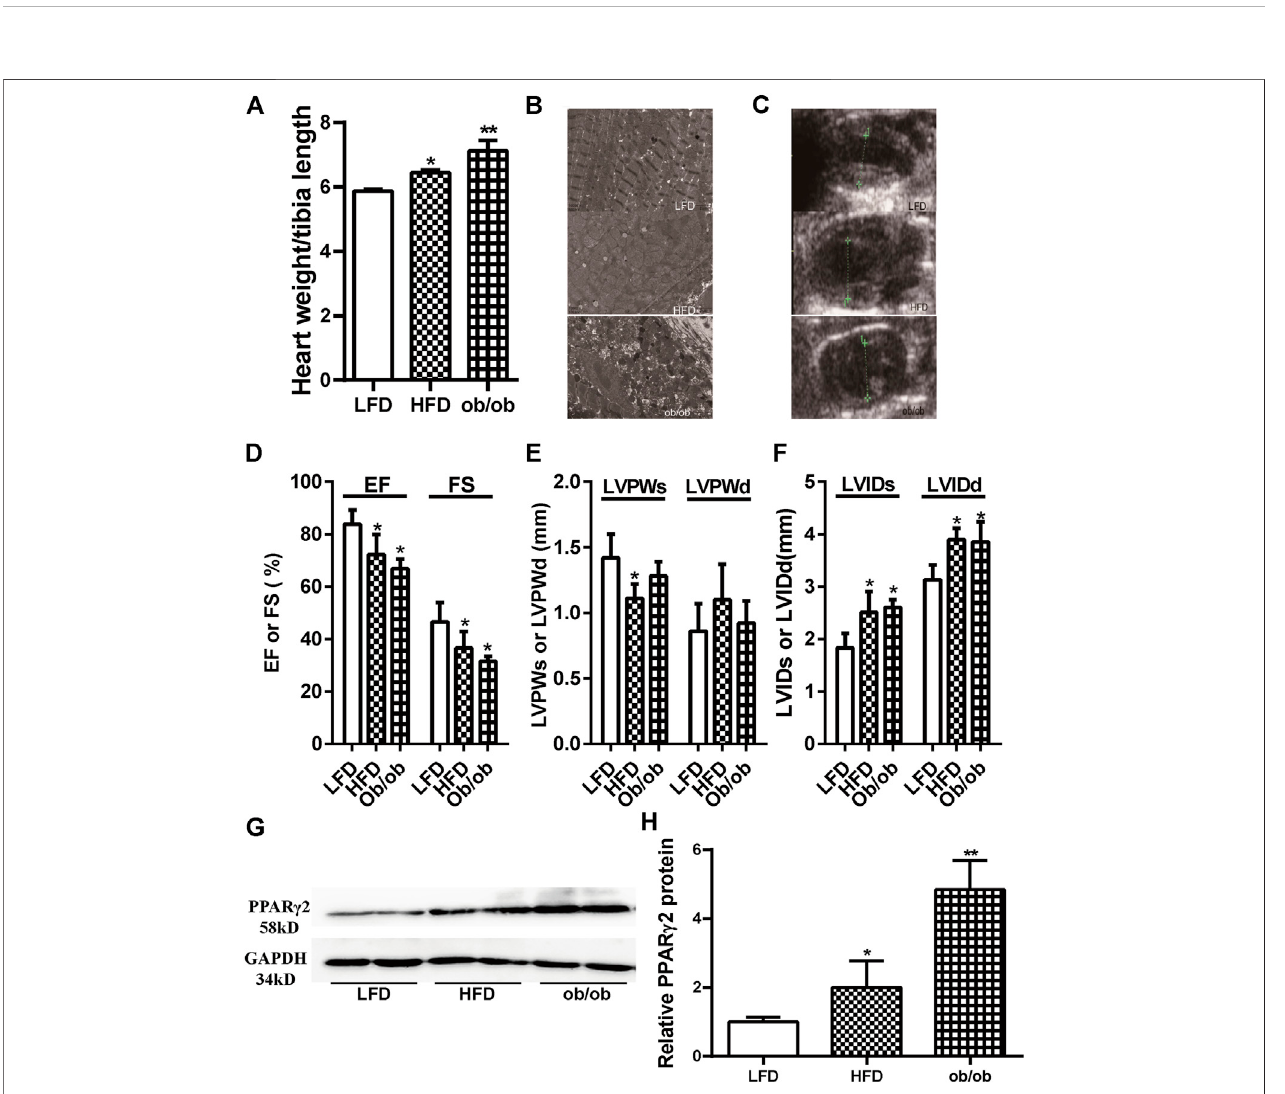
FIGURE 1 | Obesity was associated with cardiac dysfunction and ectopically upregulated PPAR γ 2 expression in the heart. (A) The ratio of the heart weight to tibia length. (B) and (C) The representative 2D echocardiograph and M-mode image of lean and obese mice. (D) Quanti fi cation of ejection fraction (EF) and fractional shortening (FS). (E) Measurements of the left ventricle wall thickness in systole (LVPWs) and diastole (LVPWd). (F) The left ventricle internal diameters in systole (LVIDs) and diastole (LVIDd). (G) Representative PPAR γ 2 bands of Western blot in heart tissues. (H) Quanti fi ed protein levels of PPAR γ 2 in the heart of the LFD group or obese mice. Mean ± SEM, n (cid:2) 5 – 8 mice per group, * p < 0.05, ** p < 0.01 vs. LFD.